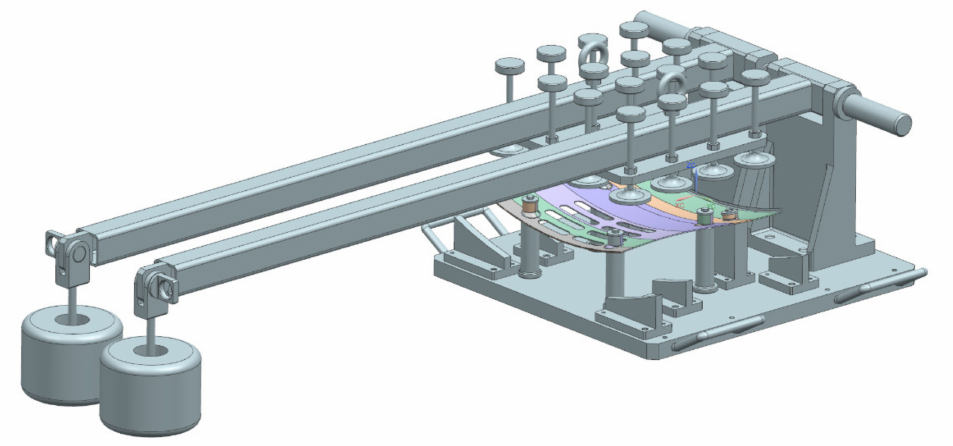
Figure 4. System for uneven panel loading during